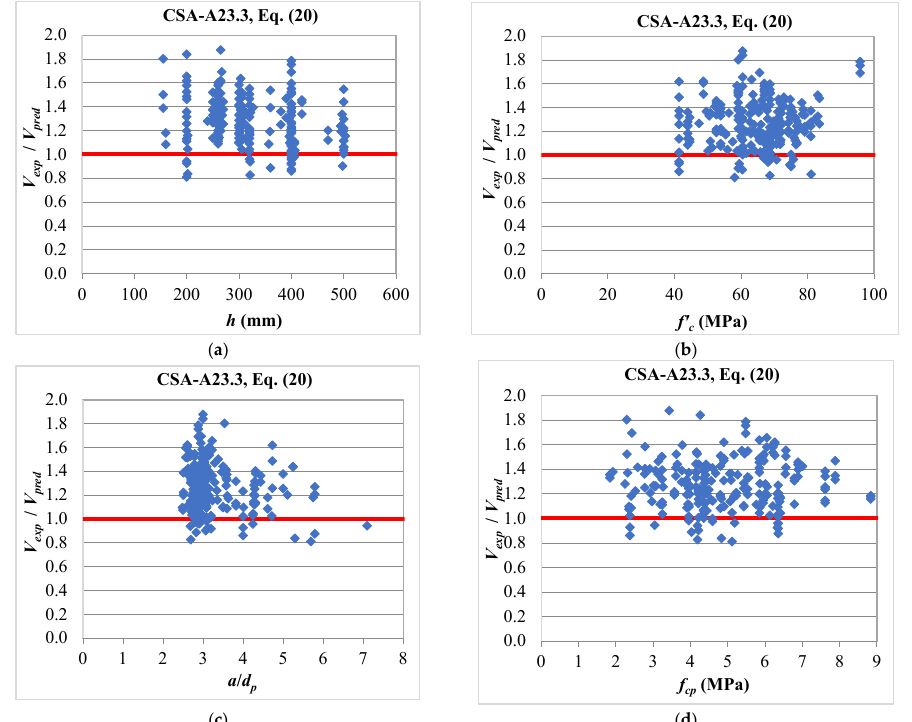
Figure 9. Predictions of the CSA-A23.3 design equation against ( a ) total thickness, ( b ) concrete compressive strength, ( c ) shear span to depth ratio, and ( d ) compressive stress due to the fully effective prestressing force.